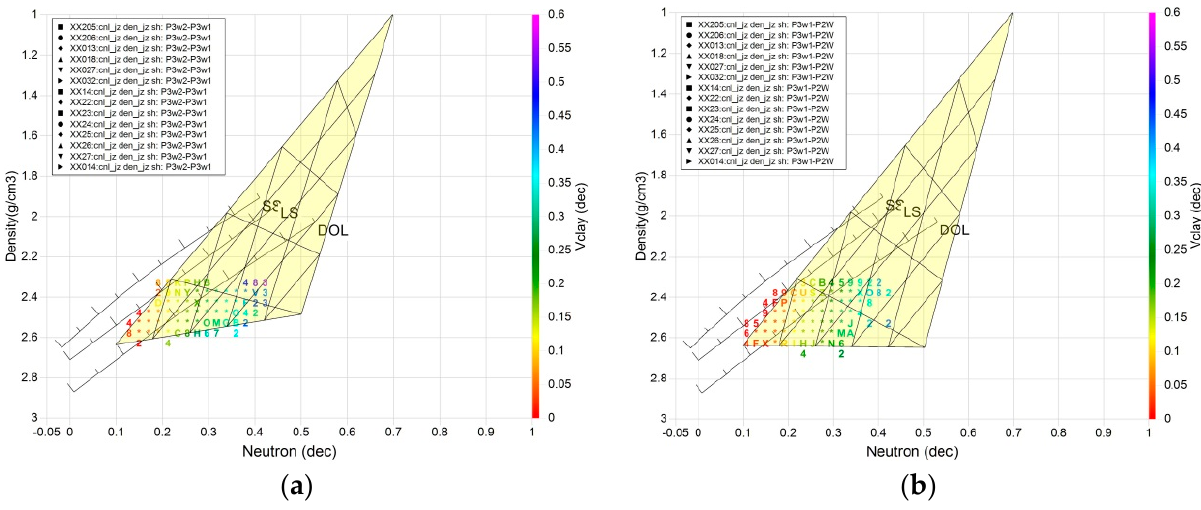
Figure 7. The neutron-density crossplot method: ( a ) Wu 2 interval; ( b ) Wu 1 interval.